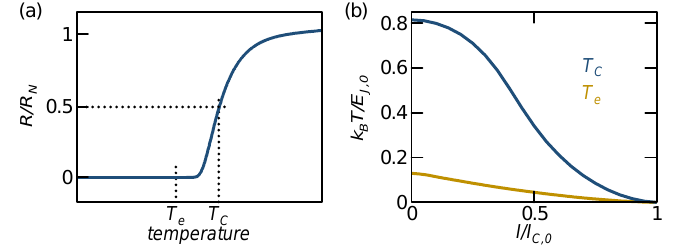
Figure 3. Definition of escape and critical temperature. ( a ) Calculated normalized resistance ( R / R N ) versus temperature calculated for a 1DJ within the RSJ model. The escape temperature ( T e ) and the critical temperature ( T C ) are indicated. ( b ) Critical temperature ( T C , blue) and escape temperature ( T e , orange) as a function of the bias current ( I ) calculated by means of the RSJ model of a